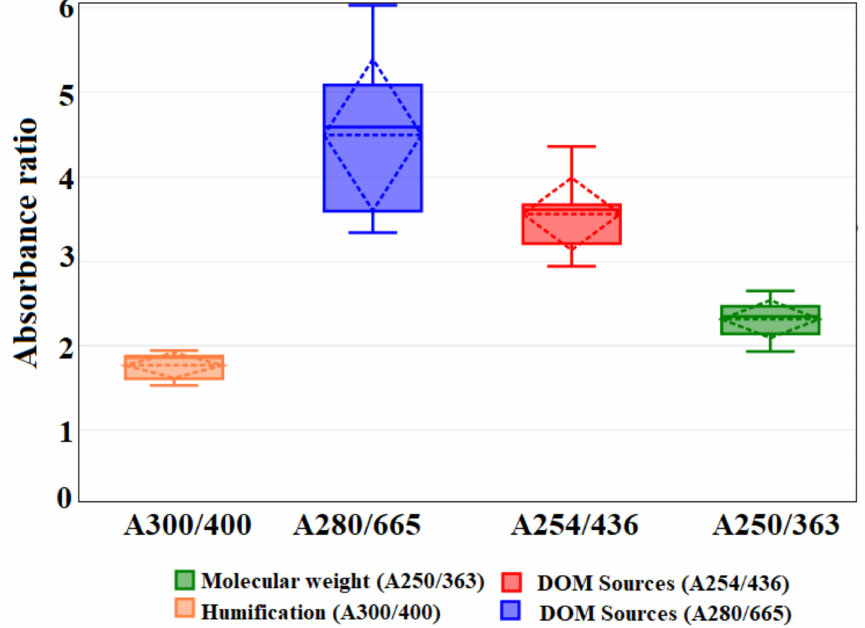
Figure 3. Box and Whisker plot of the absorbance ratios for molecular weight (A340/254), humifica- tion (A300/400), DOM sources (A254/436), and DOM sources (A280/665). Variance in DOM sources are measured at A254/436 (Mean: 3.56, SD: 0.43), and A280/665 (Mean: 4.49, SD: 0.89). DOM sources at A254/436 and A280/665 range from